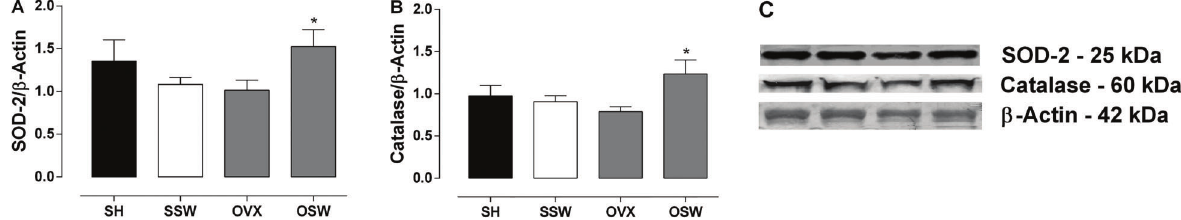
Figure 3. Protein expression of antioxidant enzymes. A , Mitochondrial isoform of superoxide dismutase (SOD-2) expression in coronary arteries; B , catalase protein expression in coronary arteries, and C , representative images of SOD-2, catalase, and b -actin membranes. SW induced an up-regulation in the expression of both enzymes in the OSW group compared to OVX (*P o 0.05). SH: sham-operated; SSW: sham plus swimming training; OVX: ovariectomized; OSW: ovariectomized plus swimming training. Data are reported as means ± SE (SH: n=6, SSW: n=6, OVX: n=7, OSW: n=7). One-way ANOVA followed by Fisher ’ s post hoc test were used for statistical analyses.